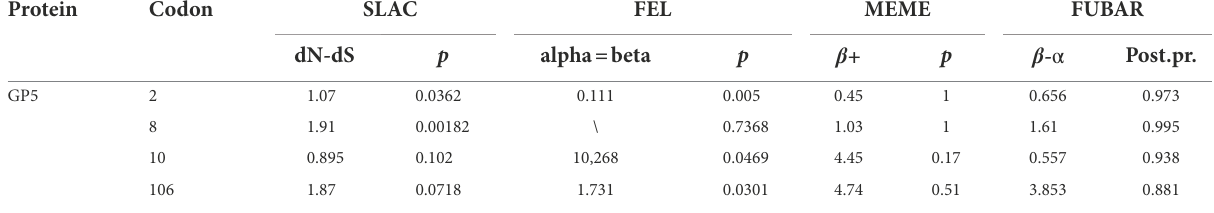
TABLE 2 Selection pressure analysis of the GP5 protein of PRRSV.